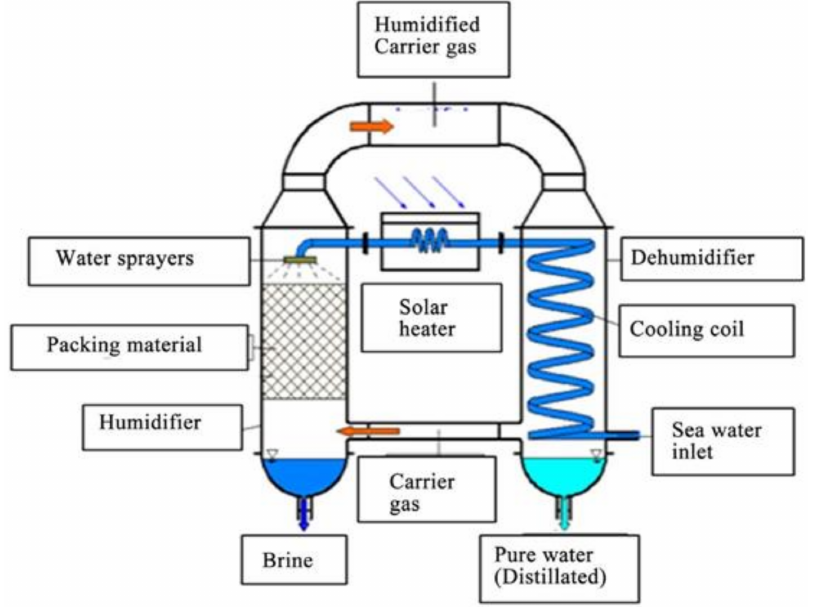
Figure 1. The simplest embodiment of the HD process